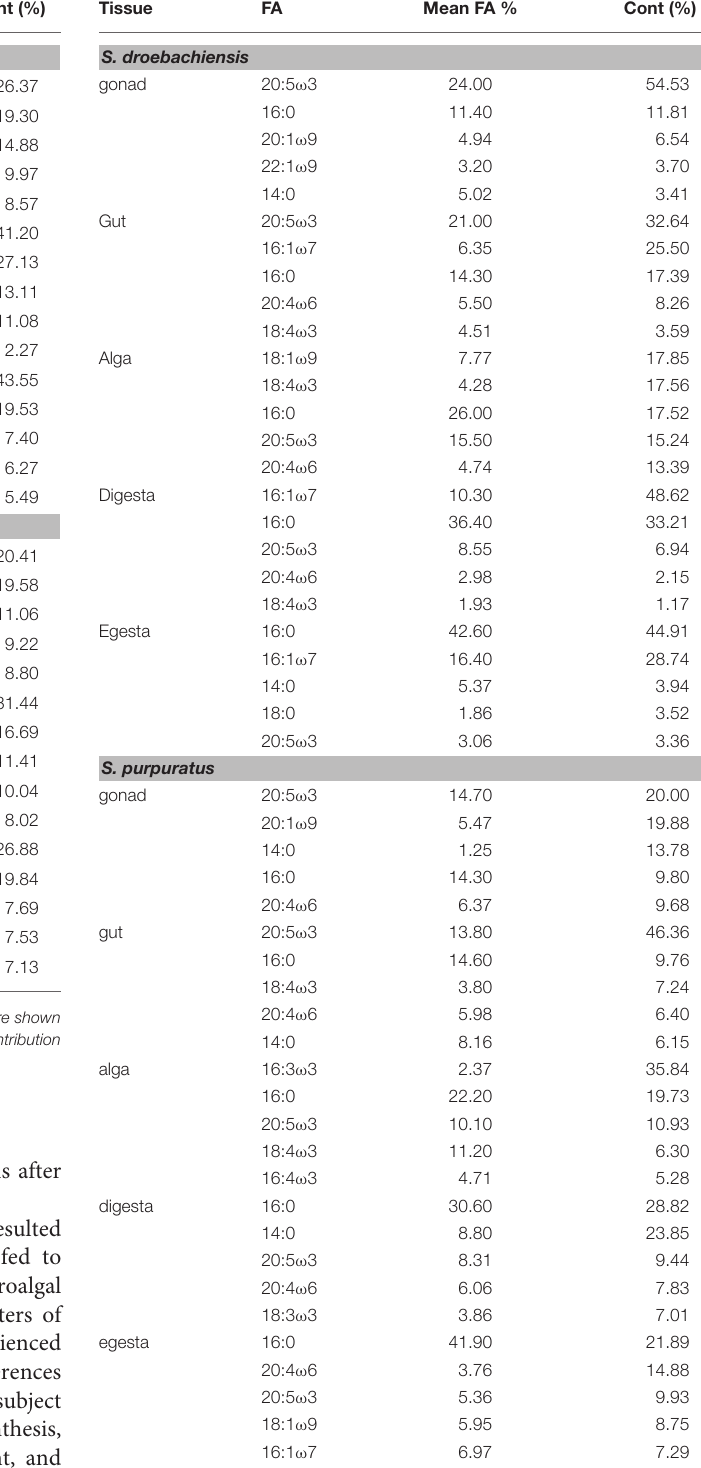
TABLE 5 | SIMPER results for analysis of combined FA of tissues from S. droebachiensis ( N = 12) and S. purpuratus ( N = 18). Tissue